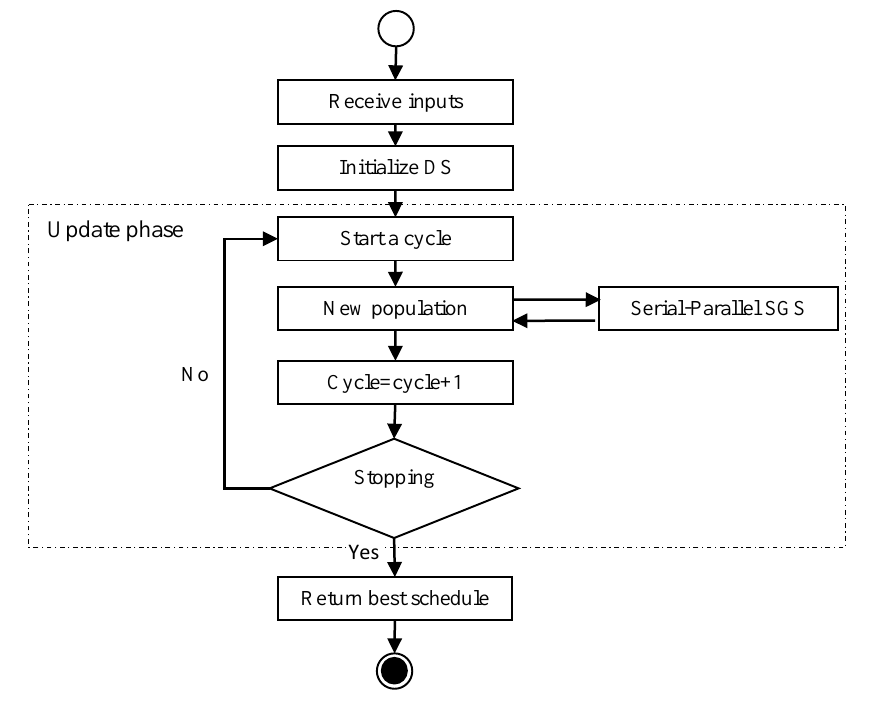
Fig. 2. Flowchart of the proposed